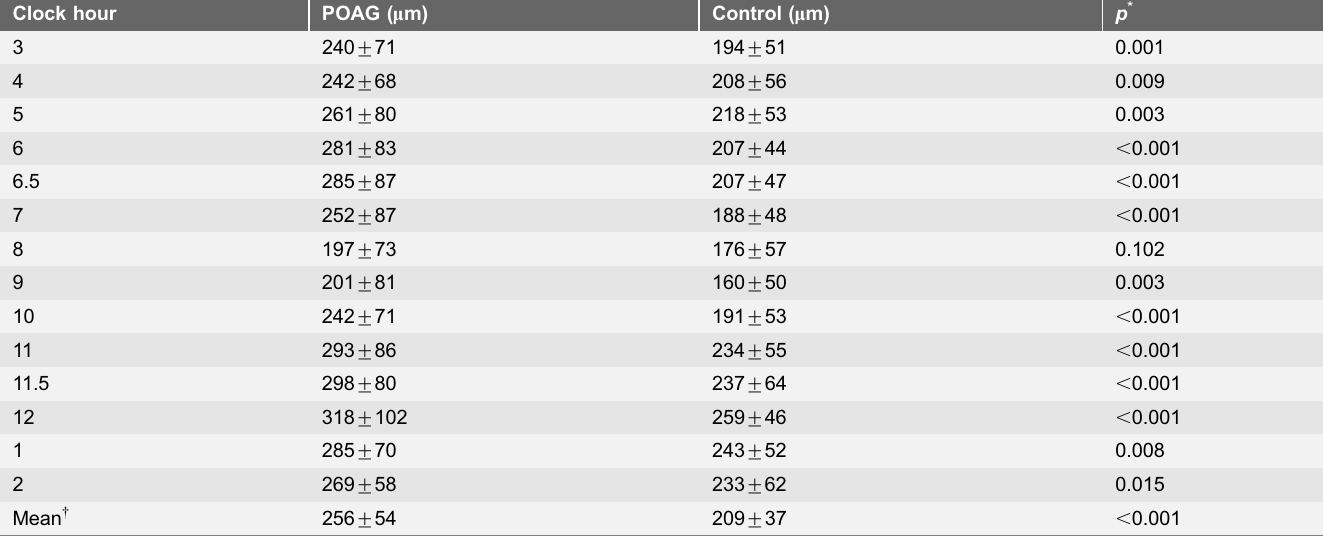
Table 4. Comparison of ALID between POAG patients and normal healthy (control) subjects.